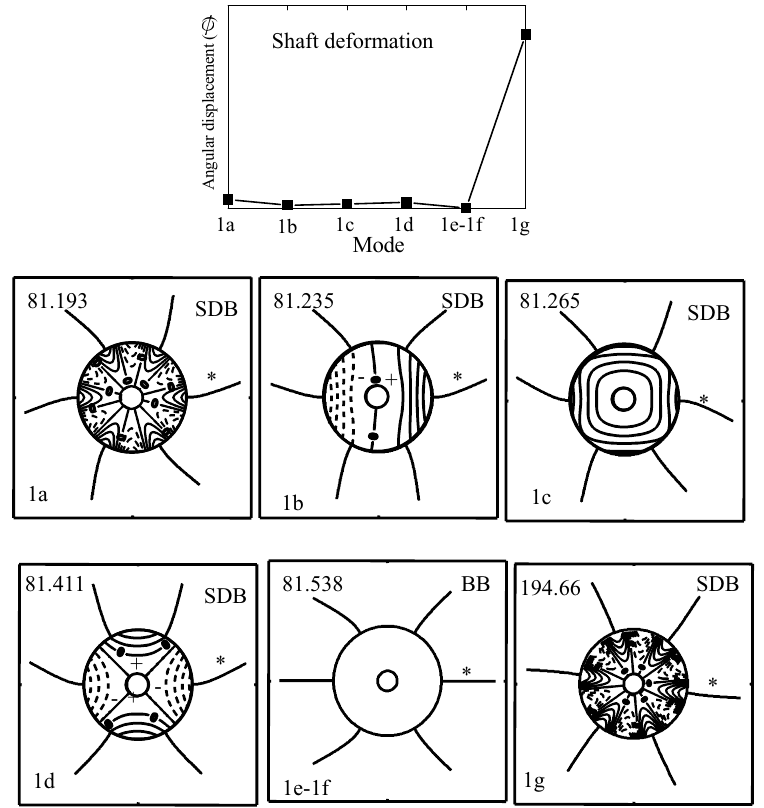
Fig. 7. The first six modes of the mistuned six-blade rotor.